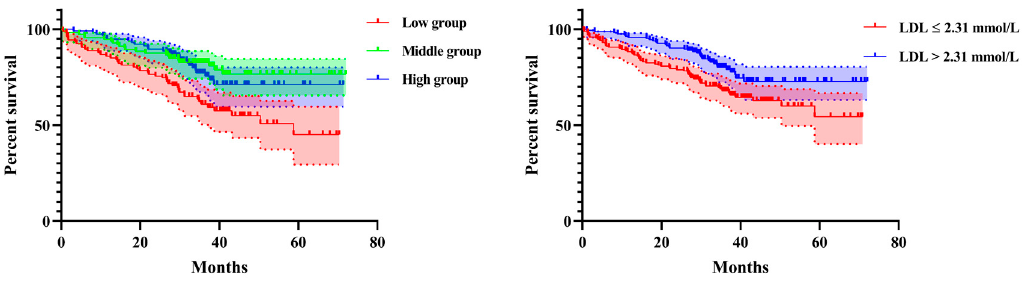
Figure 2. The Kaplan–Meier survival curve according to LDL levels and inflection point of 2.31